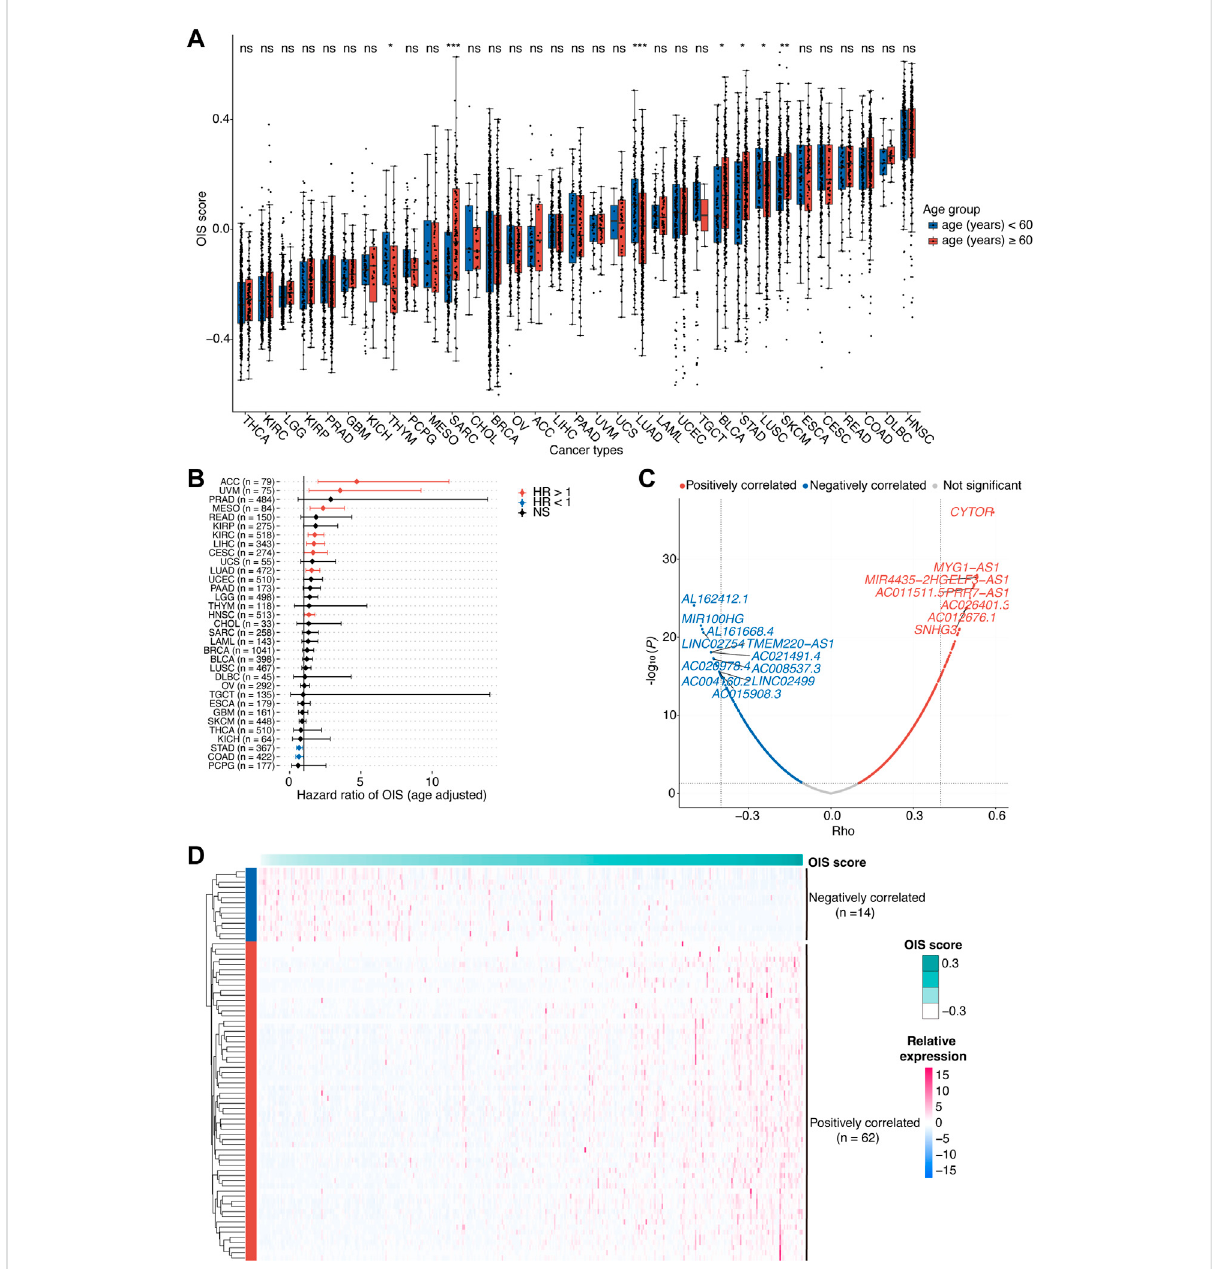
FIGURE 1 Identi fi cationofOIS-relatedlncRNAsinHCC. (A) Oncogene-inducedsenescence(OIS)scoresoftumortissuesacrosscancertypesfromTCGA. Wilcox testwasusedto assessthedifference acrossdifferentagegroups. (B) ThecorrelationbetweenOISscore andOS ofpatientsacross allcancer typesinTCGA.TheHRsand95%CIswereidenti fi edbymultivariateCoxproportionalhazardsanalyses. (C) Avolcano plotofthecorrelationbetween expression levels of lncRNAs and OIS scores in TCGA-LIHC patients. The red spots represent the statistically signi fi cant positive correlates and the blue ones represent thestatistically signi fi cant negativecorrelates.The correlation coef fi cients ( rho )and p values weredetermined by Spearman rankcorrelationanalysis. (D) Anexpressionheatmap ofOIS-relatedlncRNAsinHCCtumorsfromTCGA. OIS,oncogene-induced senescence; HCC, hepatocellular carcinoma; TCGA, the cancer genome atlas; OS, overall survival; HR, hazards ratio; CI, con fi dence